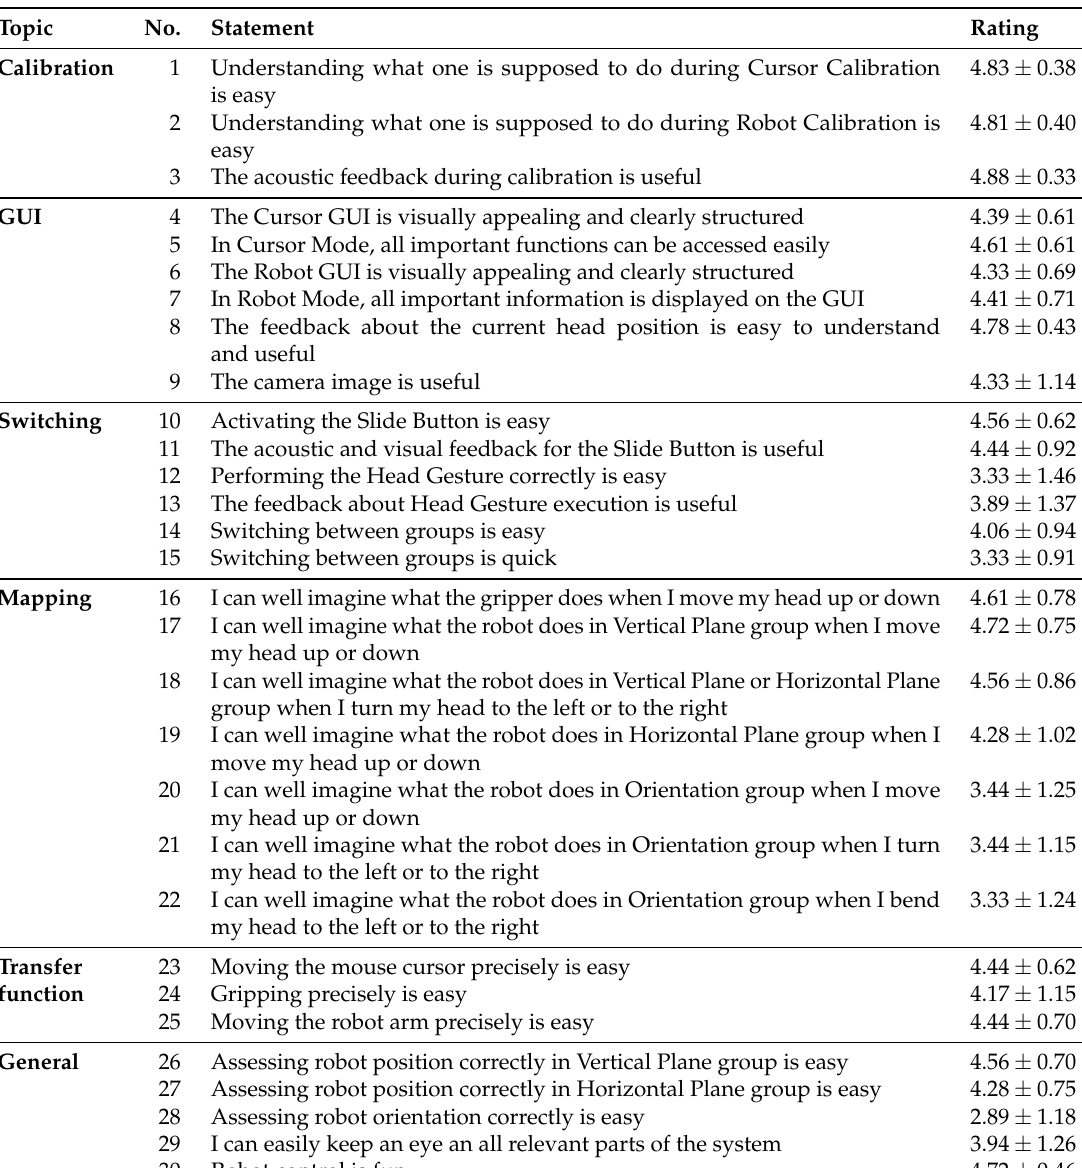
Table 2. Evaluation sheet for AMiCUS including